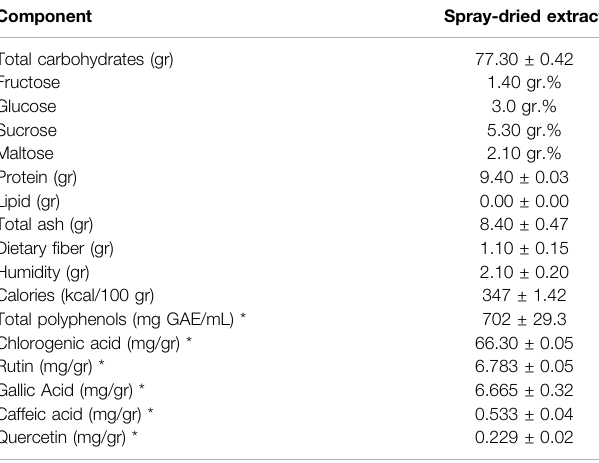
TABLE 2 | Chemical composition in the spray-dried extract. Component Spray-dried